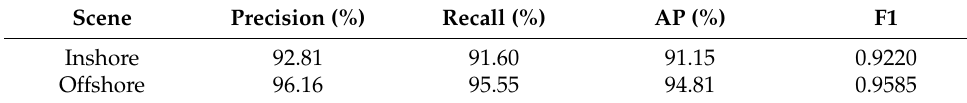
Table 9. Detection results of the proposed method in inshore and offshore scene on SSDD.